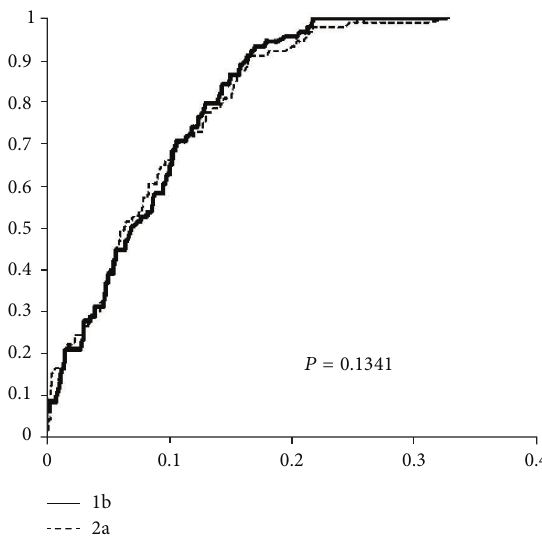
Figure 7: Results of LIBSHUFF comparison between the 1.2 and 2.1 libraries. The solid line indicates the homologous coverage curve 𝐶 𝑋 (𝐷) , and the broken line indicates the heterologous coverage curve 𝐶 𝑋𝑌 (𝐷) . The 𝑃 value is 𝑃 > 0.025 , thus indicating that the two libraries are similar to each other in OTU composition. The 𝑦 -axis represents the coverage ( 𝐶 ) while the 𝑥 -axis represents the evolutionary distance ( 𝐷